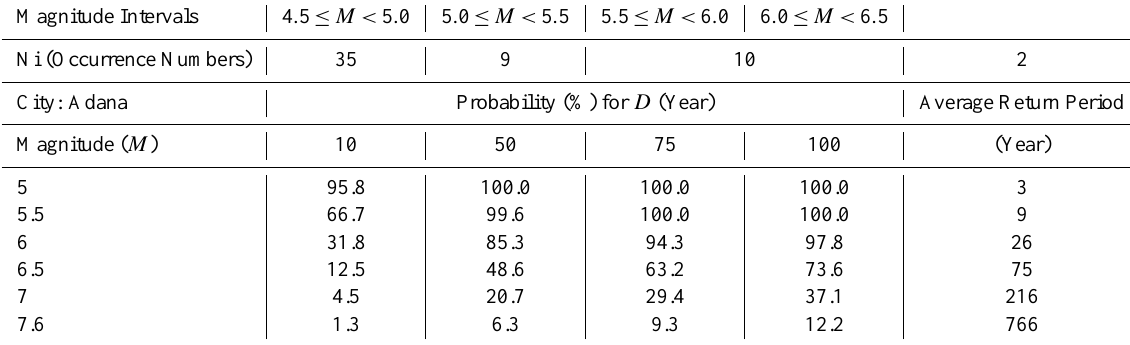
Table 3a. Earthquake occurrence probability (%) for D (Year) for Adana city. Magnitude Intervals